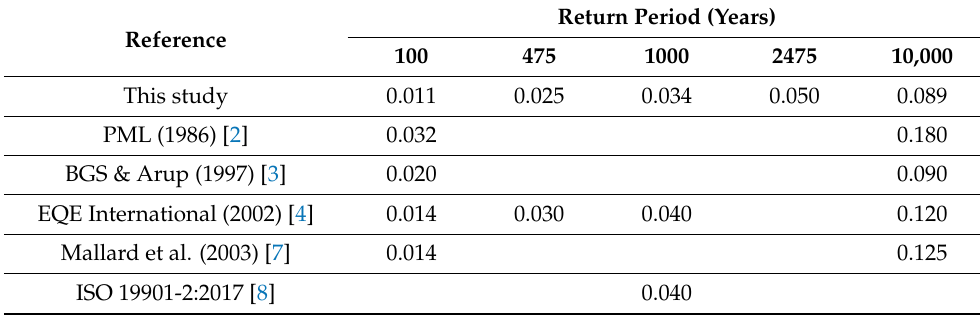
Figure 9. Mean uniform hazard spectra for different return periods (RP). Table 7. Comparison of PGA (g) values on rock for different return periods.